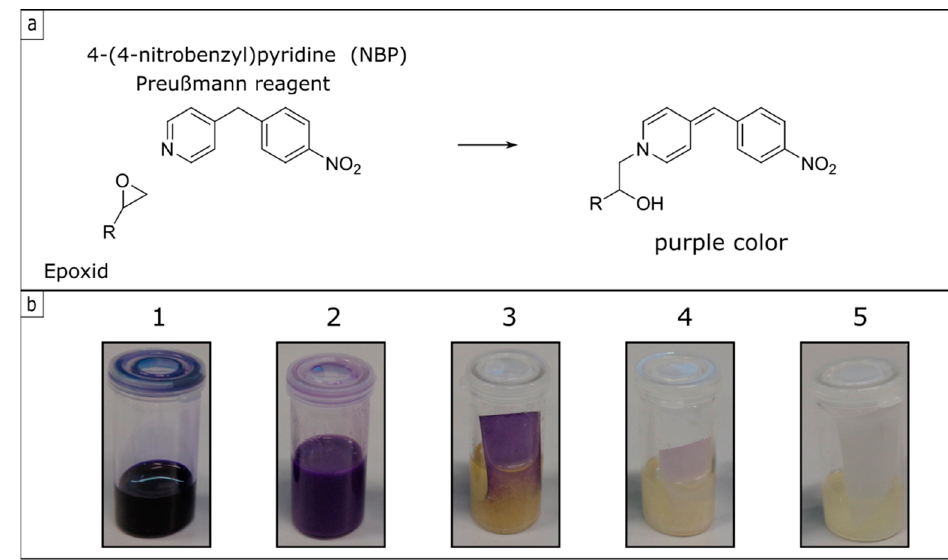
Figure 6. ( a ) Preußmann reagent 4-(4-nitrobenzyl)pyridine (NBP) and the reaction with an epoxide to the violet color, ( b ) NBS stock solution with various samples in them (1 = pure monomer GlyMA, 2 = P(FA- co -StMA- co -GlyMA 10% ), 3 = P(FA- co -StMA- co -GlyMA 10% ) on cellulose fibers prior to the cross-linking reaction, 4 = P(FA- co -StMA- co -GlyMA 10 ) on cellulose fibers after the cross-linking reaction, and 5 = pristine cellulose fiber substrate).